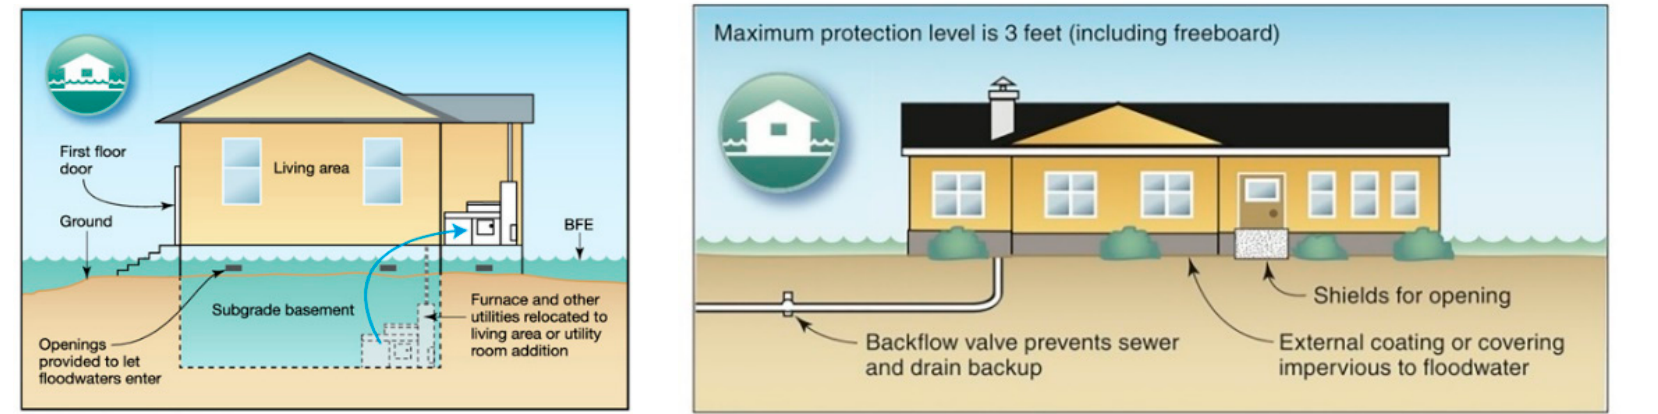
Figure 1. Example of a wet flood-proofed building ( Left ) and a dry flood-proofed building ( Right ) (Source: Federal Emergency Management Agency, FEMA [25]).